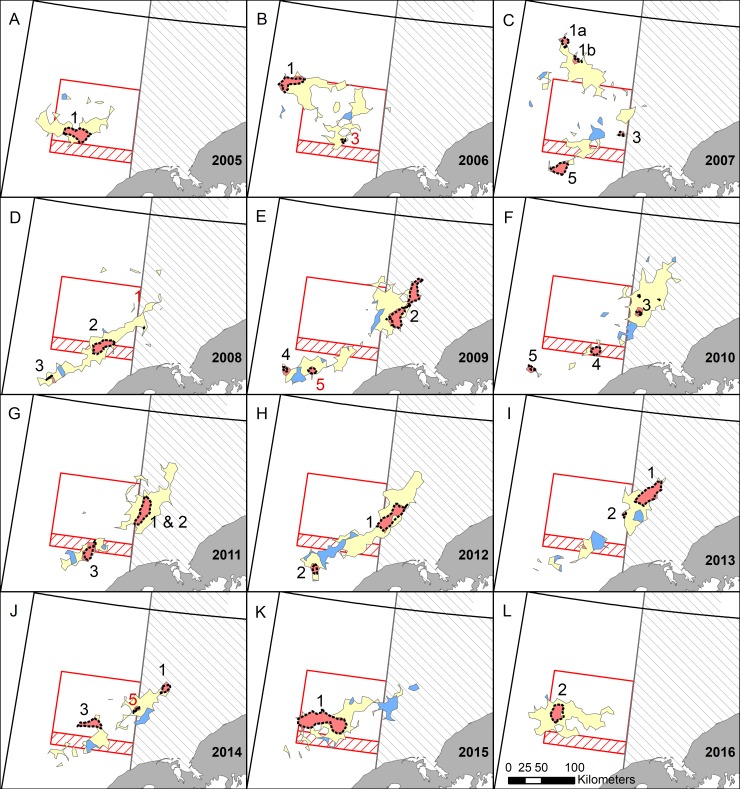
Red king crab distributions using daily fishing logs (DFLs) from the beginning of the season.The beginning of the fishing season (entire season October 15th–January 15th) was defined as the first 5% of crab caught out of total legal crab in the population. Red, blue, and yellow areas indicate locations where fishing occurred. Red areas are detectable hot spots (Gi* indicating statistically significant (α < 0.01) high catch per unit effort (CPUE)); blue areas are detectable cold spots (Gi* indicating statistically significant low CPUE); yellow areas indicate locations where CPUE was not statistically different from the mean. Black dashed lines are high-high areas using the local Moran’s I statistic on DFL data and solid black lines are hot spots using observer data (Gi* statistic). Hot spots are numbered in color for each year, black when they occur in both the full dataset (Fig 4) and the first 5% (this figure) and red when they occur in just one dataset. Areas with restrictions on trawling are outlined in red or gray and described in Fig 1.